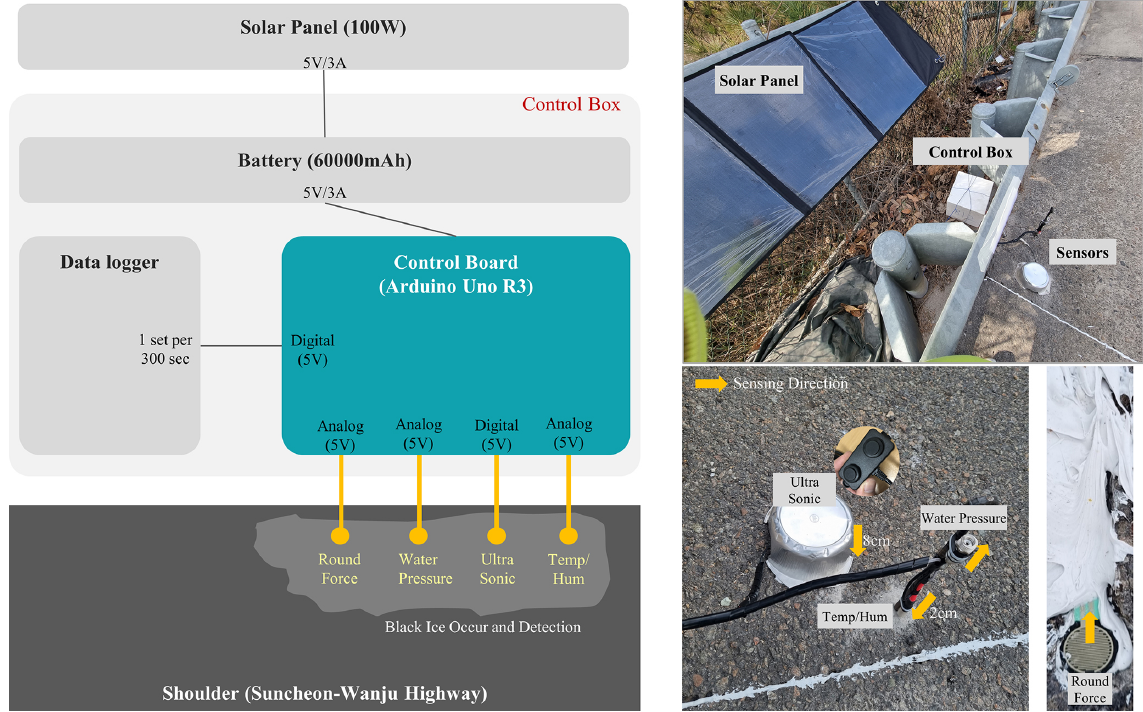
Figure 4. Configuration and installation photo of multi-sensor for black ice detection. The sensing part of the round force and water pressure sensor faces upward, and the sensing part of the ultrasonic and temperature–humidity sensor faces